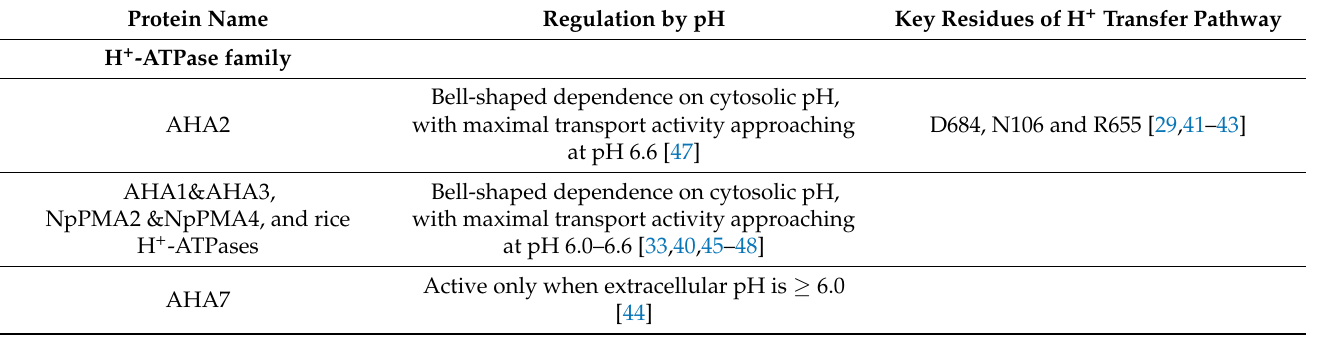
Table 1. Functional regulation by extracellular and/or cytosolic pH and key residues for H +